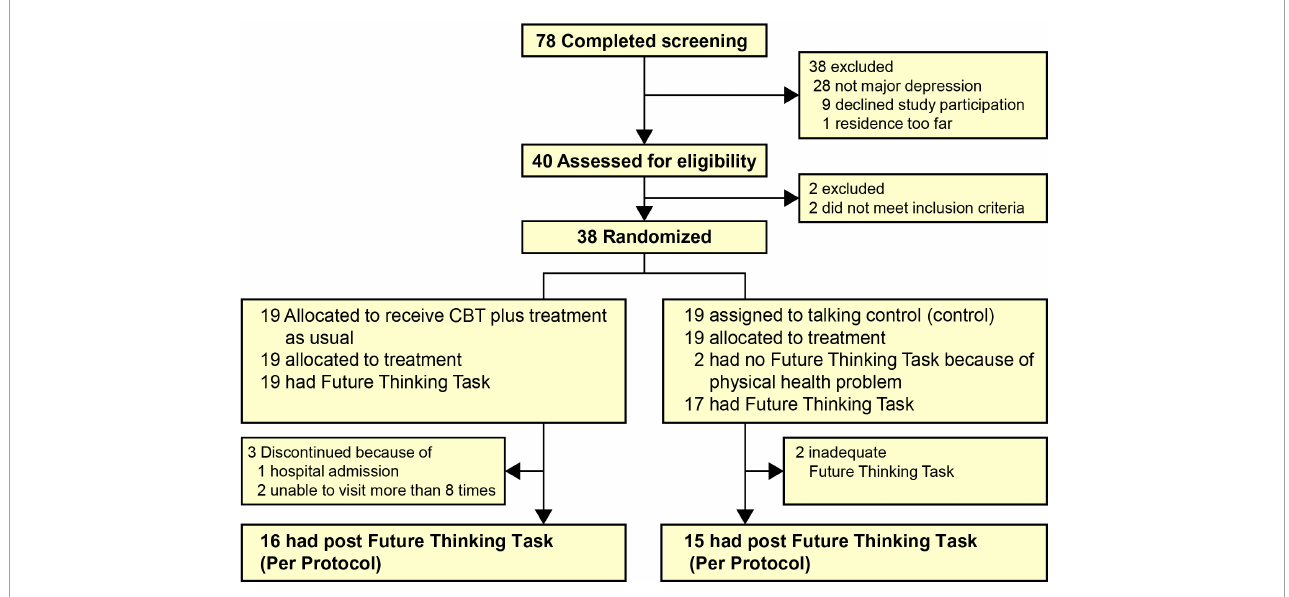
FIGURE2 CONSORT diagram of the participant flow of the study. CBT, cognitive behavioral